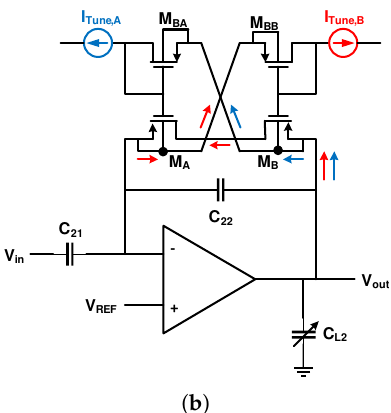
Figure 6. ( a ) Schematic of a three-stage amplifier. ( b ) Second-stage amplifier tunes the high and low-cutoff